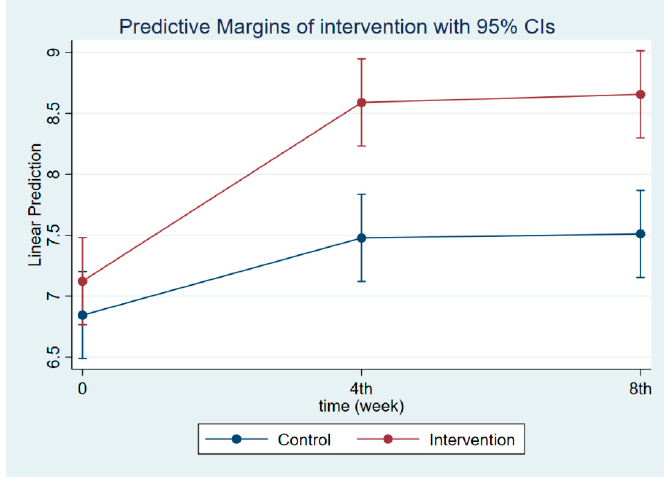
Figure 6. Maternal practice regarding CDM at follow-ups 1 and 2.